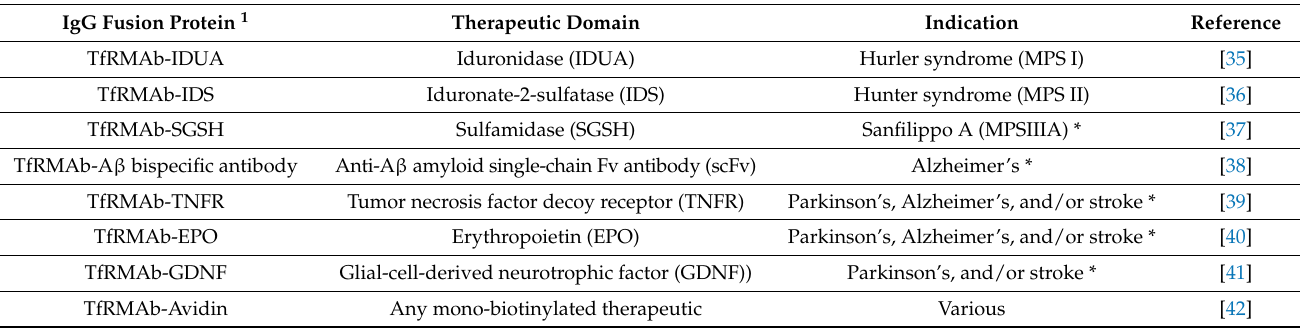
Table 2. Brain-penetrating mouse IgG fusion